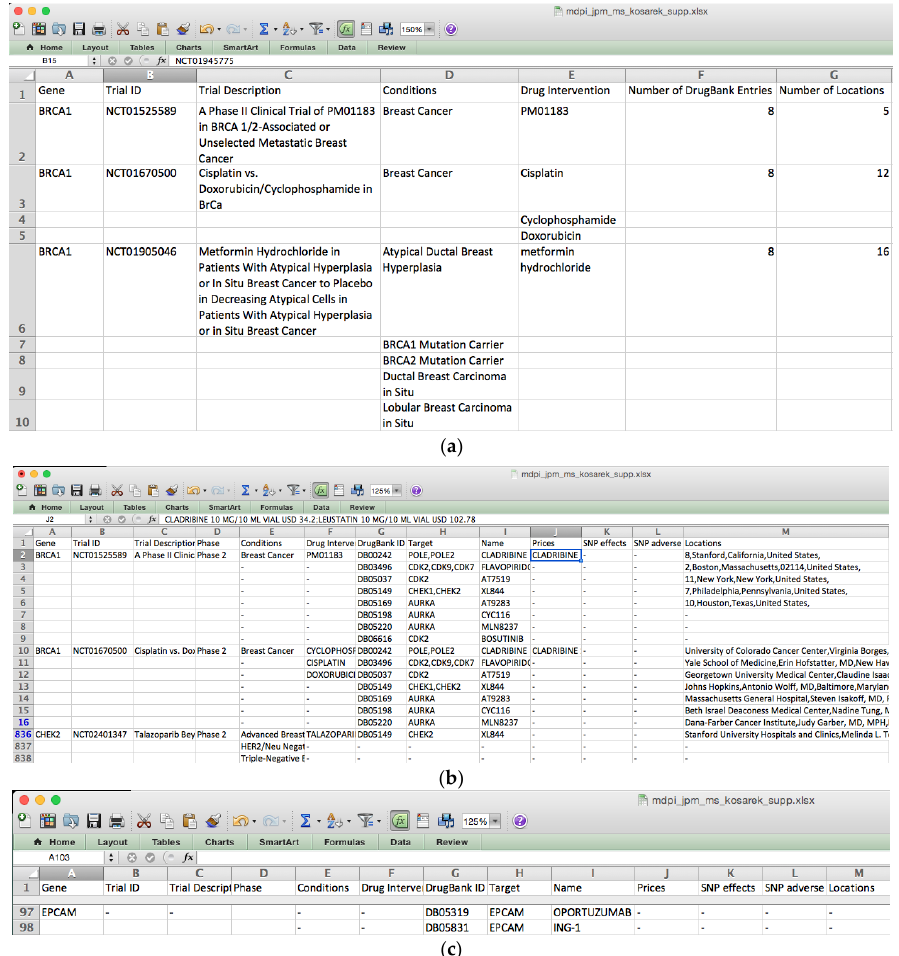
Figure 2. IDICAP reports. In each execution, IDICAP produces two tab-delimited reports that can